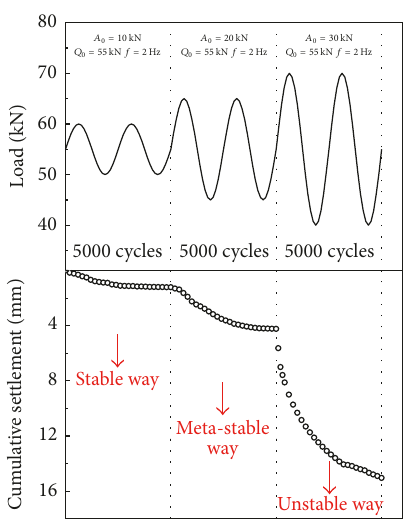
Figure 8: Cumulative settlement of X-section pile with variable loading amplitudes.